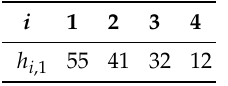
Table 4. The Holding cost of components at level 1.